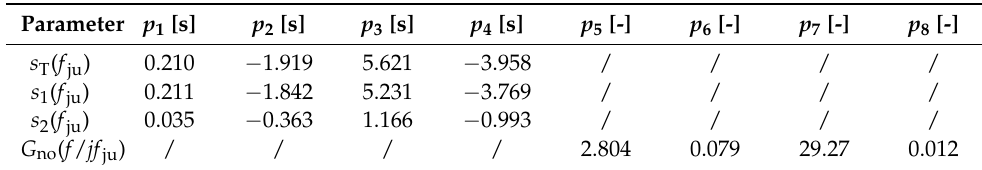
Table 3. ∆ t l ( f ju, l ) denotes the time lag shift, which follows a normal distribution N (0, σ 2 )